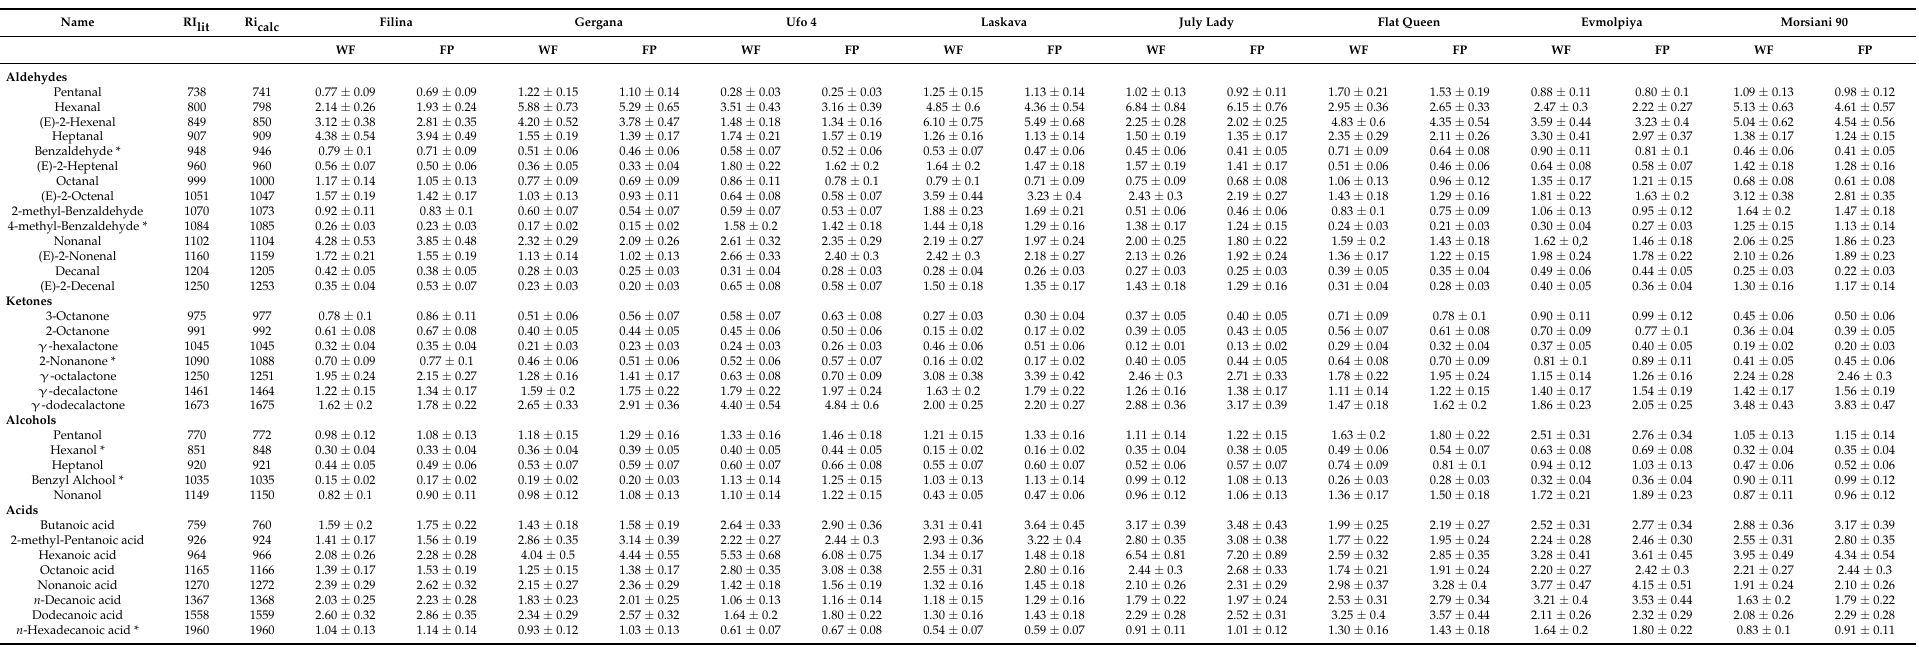
Table 2. Identified volatile compounds in peach fruit (WF) and pulp (FP) of 8 varieties analyzed by HS-SPME-GC-MS. The results are given as % of total ion